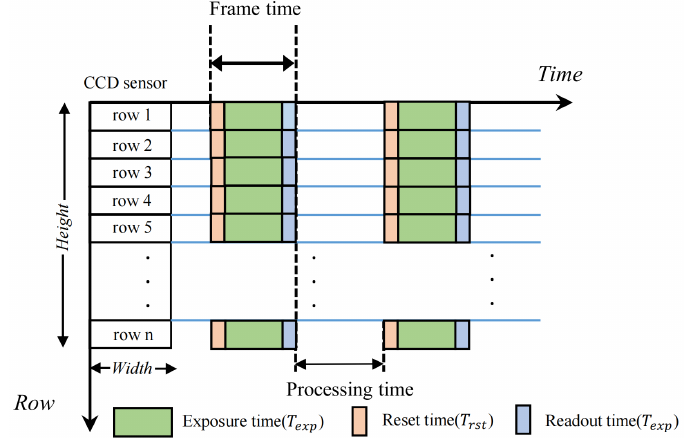
Figure 1. Sketch map of the global shutter of the CCD sensor.